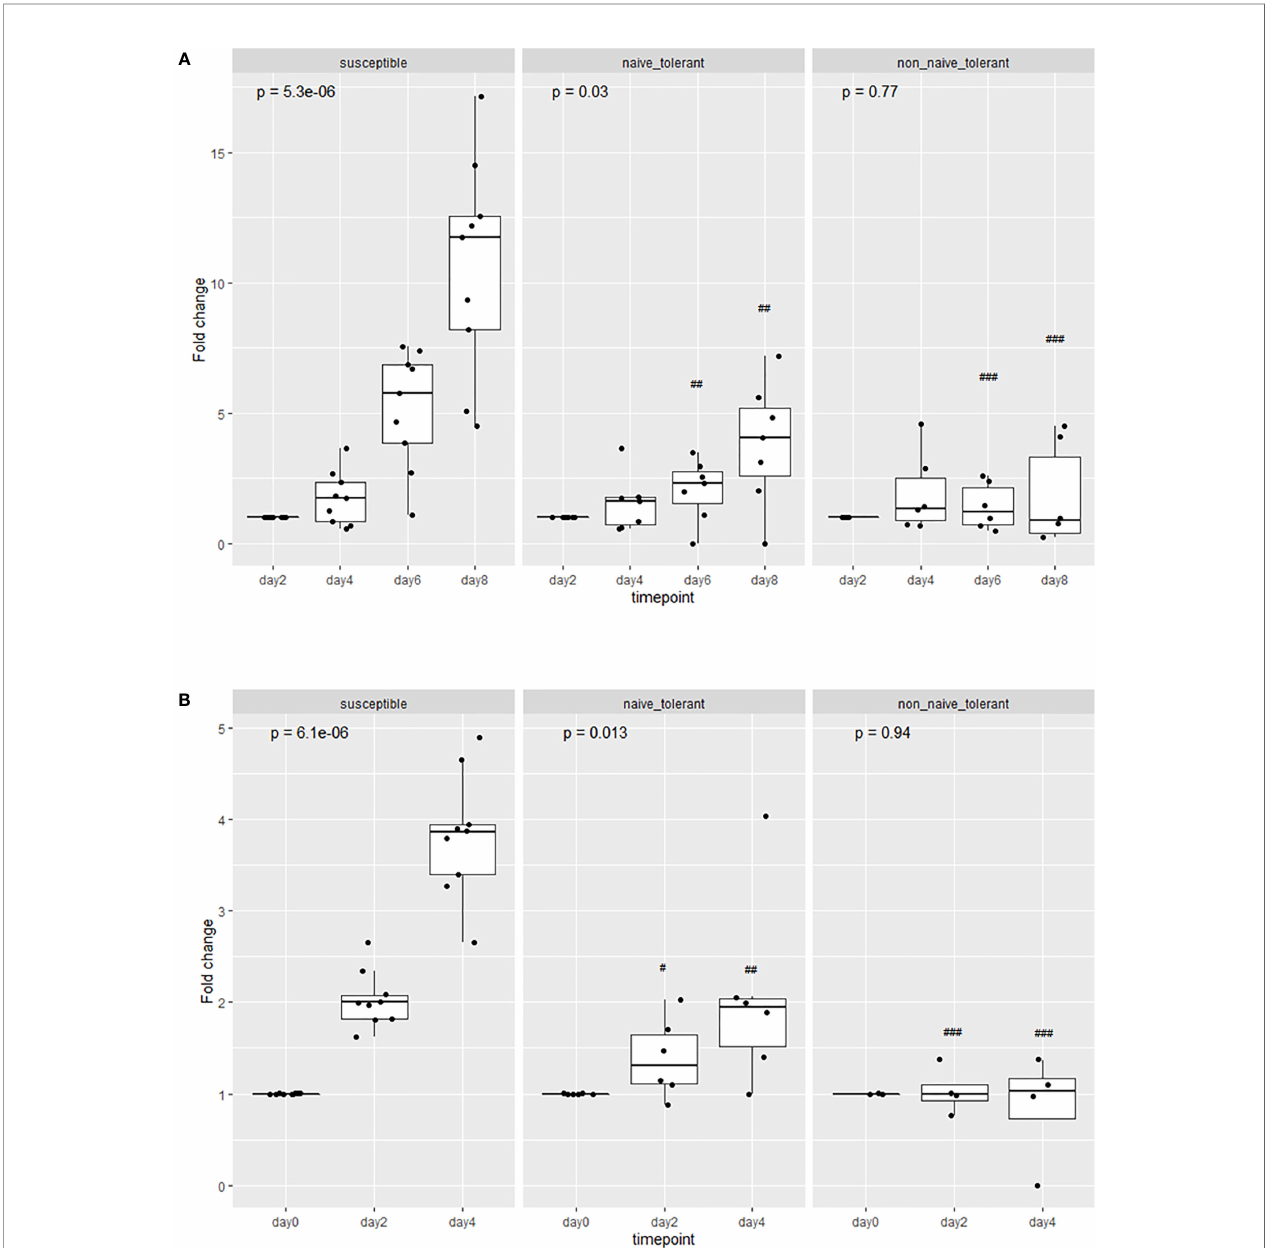
FIGURE 2 | Proliferation of cells from susceptible and tolerant animals infected in vitro . The cells were collected from tolerant animals both before (naive) or after (non-naïve) the fi eld study. The proliferation is represented as the group means of the fold changes in the number of live cells in each culture. Analyses were performed during the fi rst (A) and the second week (B) of culture following infection. In panel (B) , day ‘ 0 ’ refers to the fi rst day of counting (8 days after infection). The p values represent the probability of a difference in the fold change at different days within each group (Kruskal-Wallis test). The probability of a difference in fold change at the same day between susceptible and tolerant populations is shown as ## p < 0.01; ### p < 0.001 (Wilcoxon